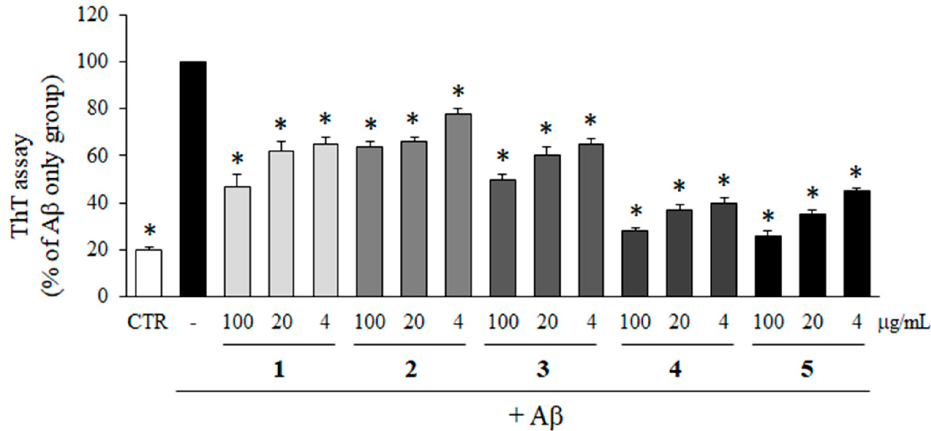
Figure 4. Effects of compounds isolated from M. glyptostroboides on A β aggregation. A β was incubated with 4, 20 and 100 µ g/mL of compounds 1 – 5 . In case of control group, DMSO was added instead of test samples. After 24 h, the aggregation of A β was determined by ThT assay. All data represents the mean ± SD of three different experiments. * p < 0.05, significantly different from A β only group.